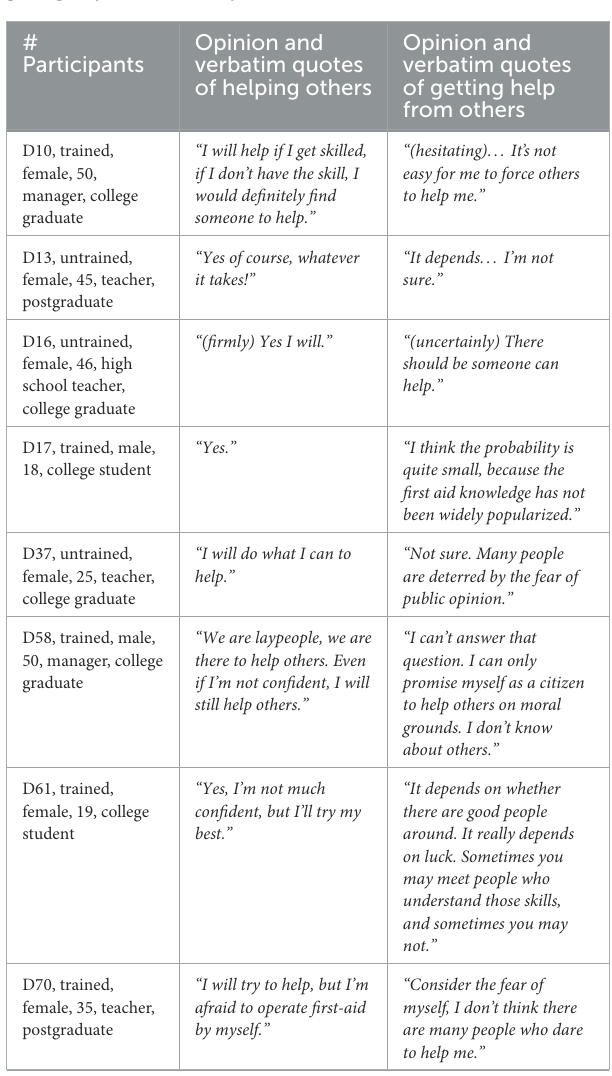
TABLE 3 Demand-side respondents’ varied views on helping others and getting help from others in